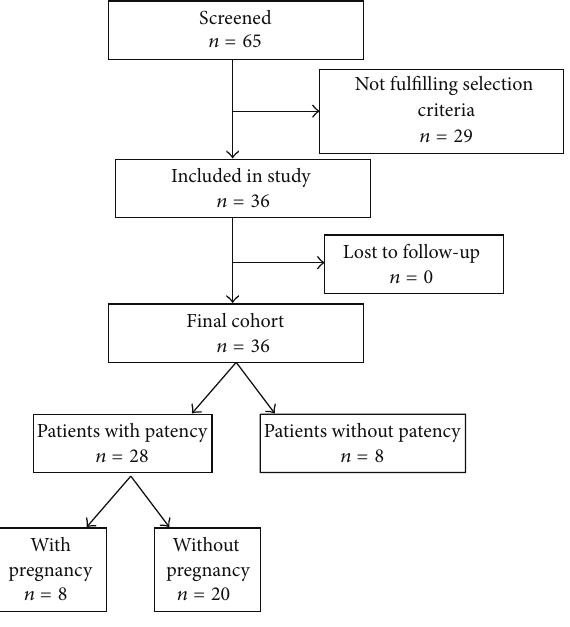
Figure 1: Patient